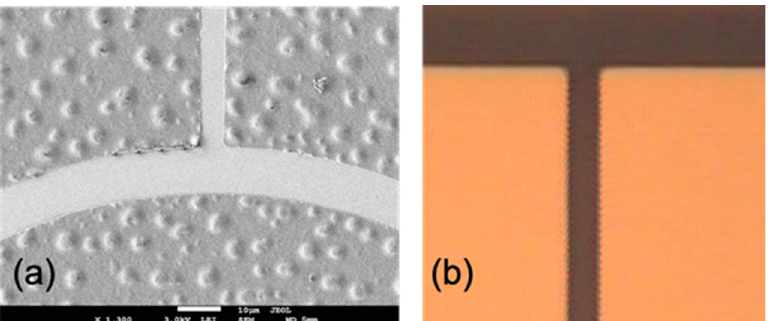
Figure 13. SEM image of ( a ) Au-based Ti/Al/Ni/Au ohmic contact annealed at 900 °C [75], and ( b ) Au-free ohmic contact (Ti/Al/Ti/TiN) annealed at 950 °C. Figure reproduced with permission from AIP Publishing.